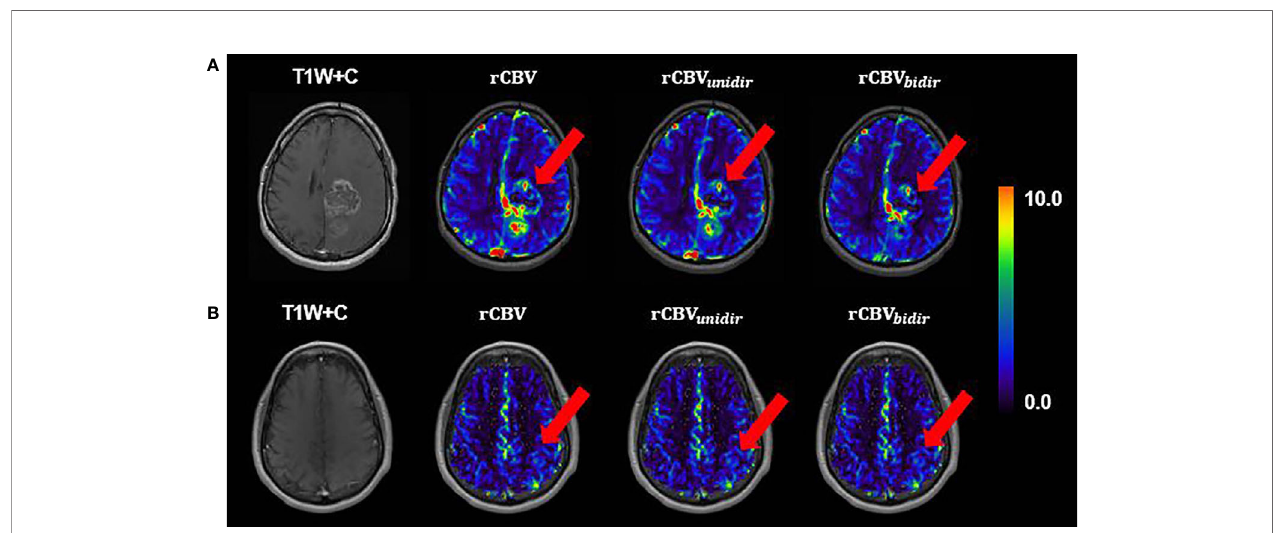
FIGURE 4 | A slice example of T 1 -weighted postcontrast overlaid with uncorrected, unidirectional corrected and bidirectional corrected rCBV maps from left to right, respectively, (A) for enhancing glioma patient (B) for nonenhancing glioma; both from TCIA dataset.